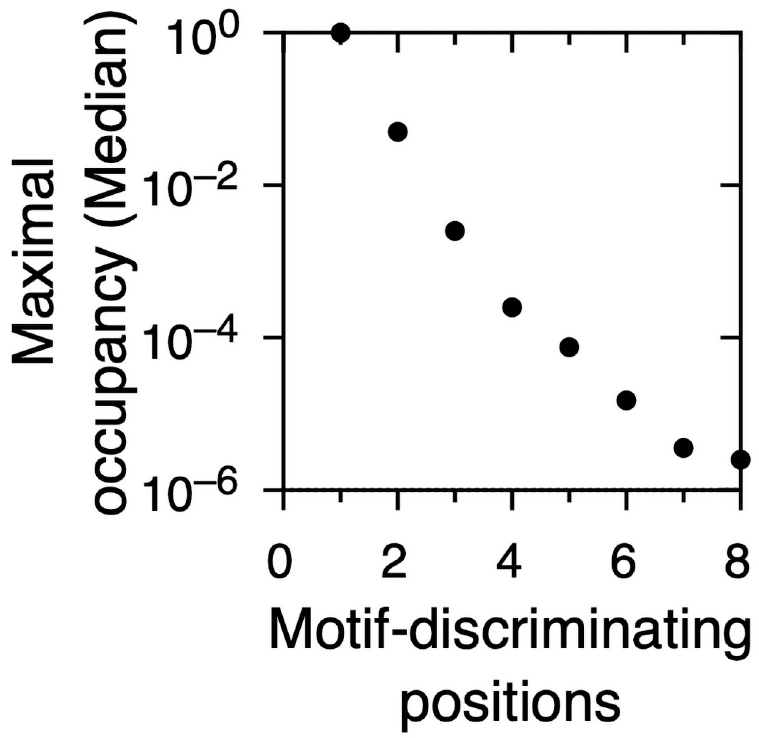
Fig 6. Maximal occupancy of the protein sequence space by linear motif classes as a function of the number of motif-discriminating positions and protein alphabet size. Maximal occupancy of the protein sequence space for different numbers of motif-discriminating